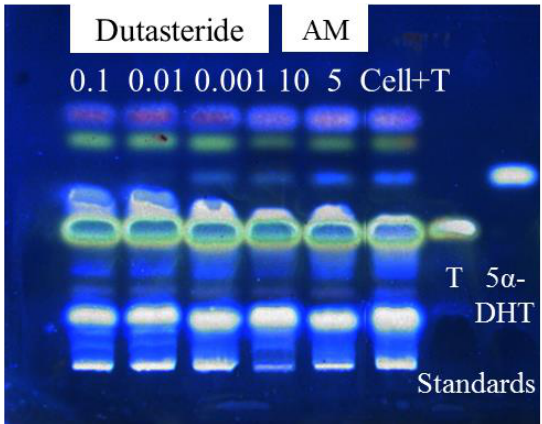
Figure 2. 5 α -R1 inhibitory activity of AM at 5 and 10 µg/mL (6.65% and 52% inhibition, respectively) and dutasteride at 1, 0.01 and 0.001 µg/mL (0%, 0% and 16.5% inhibition, respectively) using HHDPC-based assay system coupled with non-radioactive TLC detection technique. Cell+T is the internal